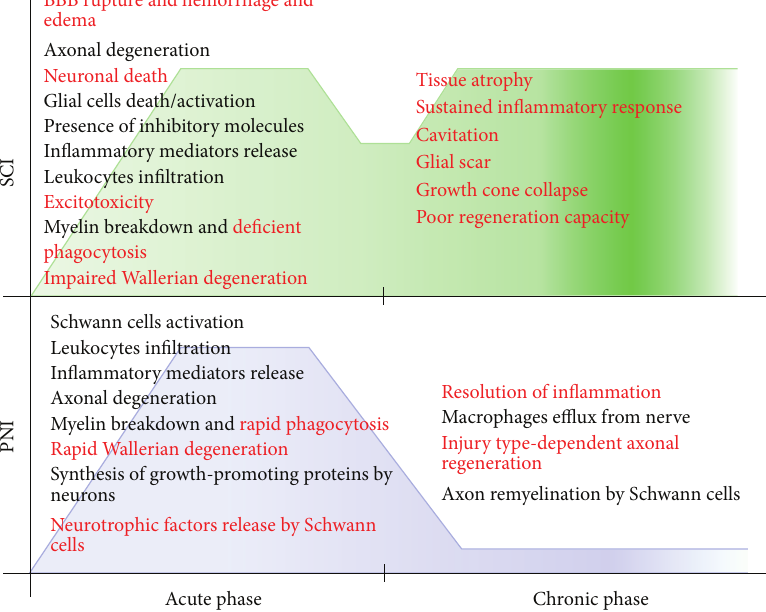
Figure 4: Commonalities (in black) and differences (in red) between SCI and peripheral nerve injury (PNI). Soon after a traumatic injury, both spinal cord and peripheral nerves elicit a rapid and robust inflammatory response (acute phase), whereas at later time points (chronic phase) SCI presents a second wave of inflammatory cells recruitment, which is detrimental to axon regeneration. Conversely, in peripheral nerves there is a marked resolution of the inflammatory response, which is correlated with successful regenerative process. Green and blue backgrounds represent the inflammatory curves after SCI and PNI,